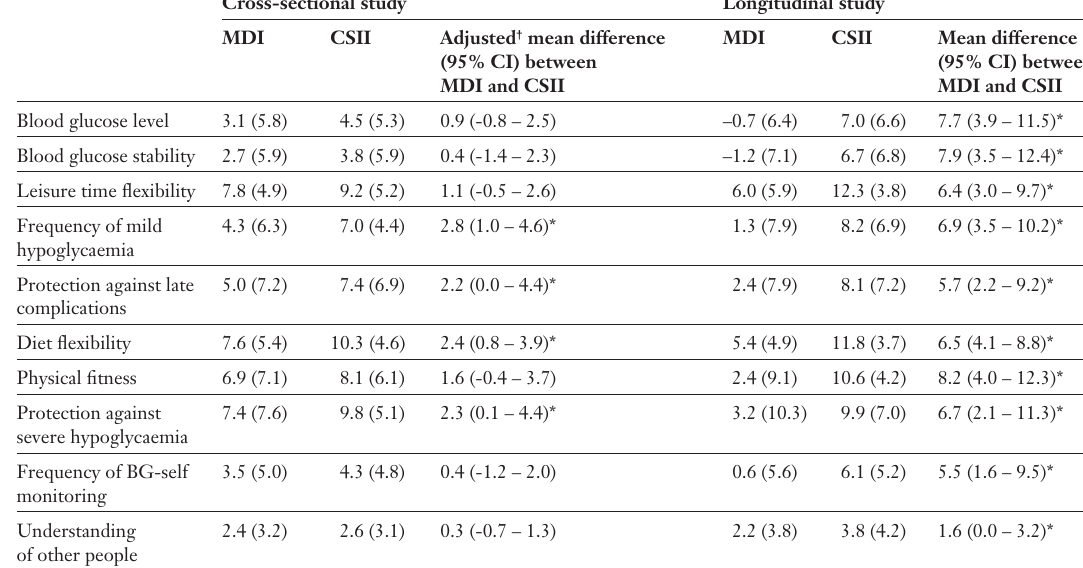
Preference-weighted treatment satisfaction score (PWTSS): mean (standard deviation). A higher value indi- cates a higher satis- faction with the indi- vidual